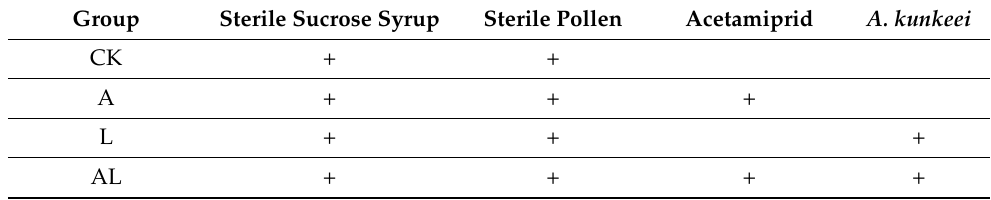
Table 1. Experimental design of the four study